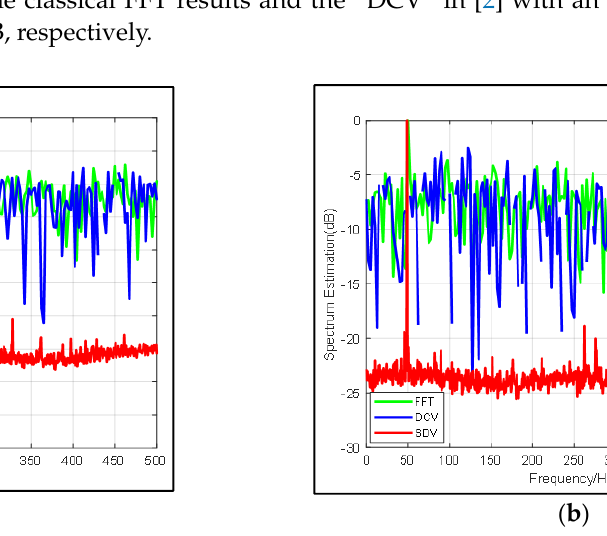
Figure 2. Comparison of frequency spectrum estimation results from FFT (blue line), DCV (green line) and SDV (red line) with ( a ) SNR = − 10 dB and ( b ) SNR = − 20 dB.